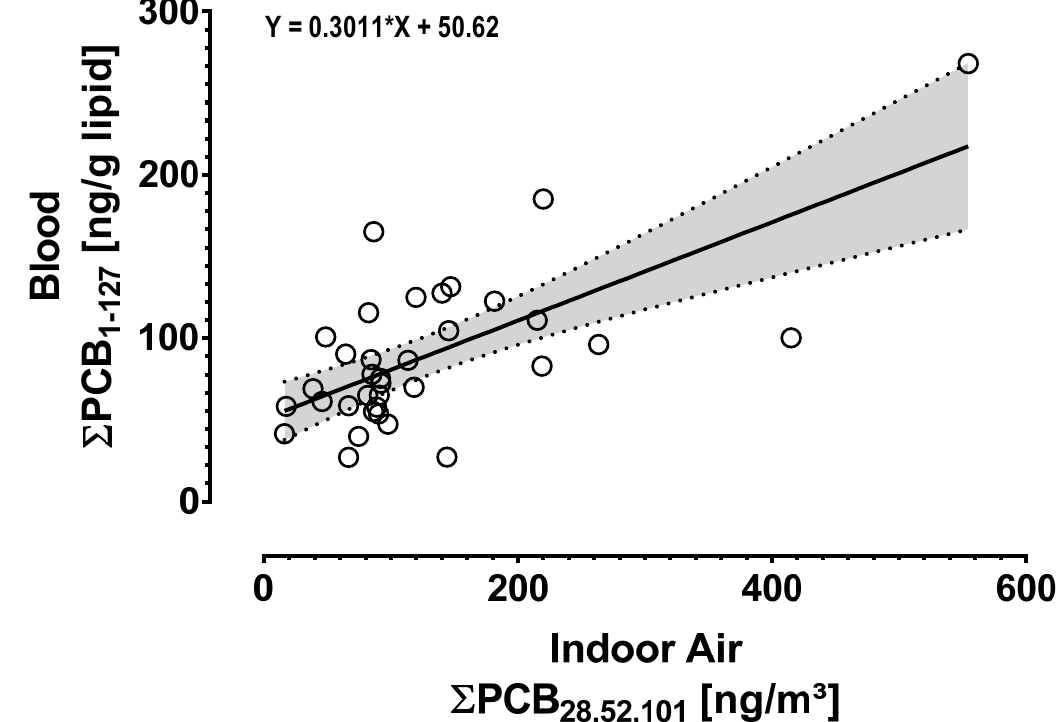
Figure 4. Linear regression between ∑ PCB 28,52,101 in indoor air and ∑ PCB 1–127 in blood ( n = 35) (R 2 = 0.46, F(1,33) = 27.94; p < 0.001). The solid line is the regression line superimposed over a scatter plot of the data and the dotted lines show the 95% confidence interval of the fit. Table 3. Blood burden of ∑ PCB 28,52,101 and ∑ PCB 1–127 (ng/g l.w.) due to exposure to ∑ PCB 28,52,101 in indoor air (ng/m 3 ).